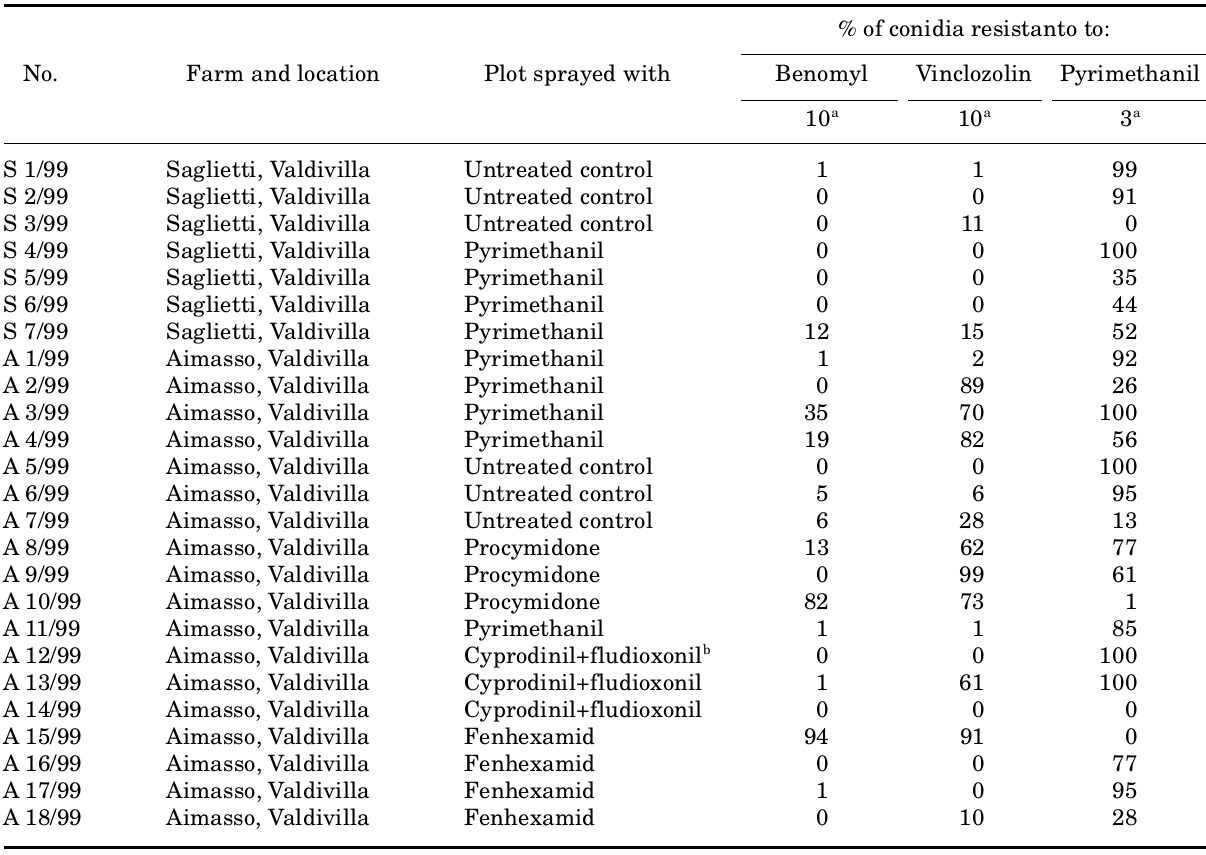
Table 4. Results of a survey carried out in 1999 to detect resistance of Botrytis cinerea to different classes of botryticides in two vineyards, cv. Moscato, where experimental trials were carried out.